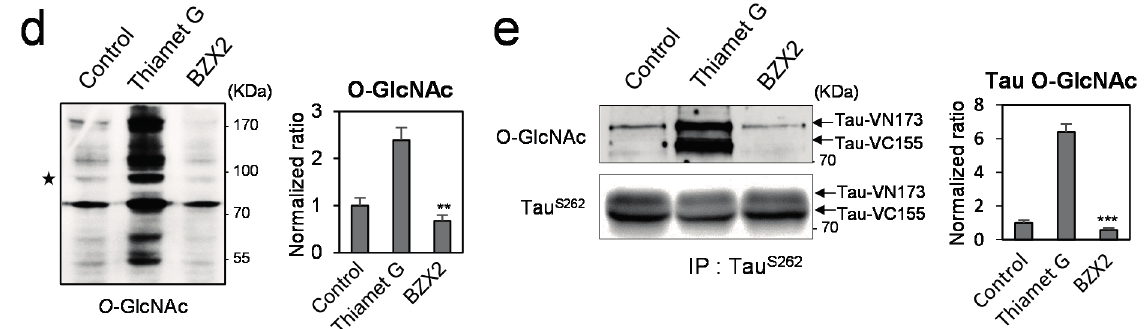
Figure 1. The opposite effects of OGA ( O -GlcNAcase) and OGT ( O -GlcNAc transferase) inhibitors on tau pathology. ( a , b ) Tau-BiFC cells were treated with Thiamet G or BZX2 (0, 10, 30 and 100 µM) for 24 h. Then, cellular responses of tau-BiFC fluorescence were imaged by using Operetta ® (PerkinElmer™, Waltham, MA, USA) ( a ) and quantified by Harmony 3.1 software (PerkinElmer™, Waltham, MA, USA) ( b ). Error bars represent the standard